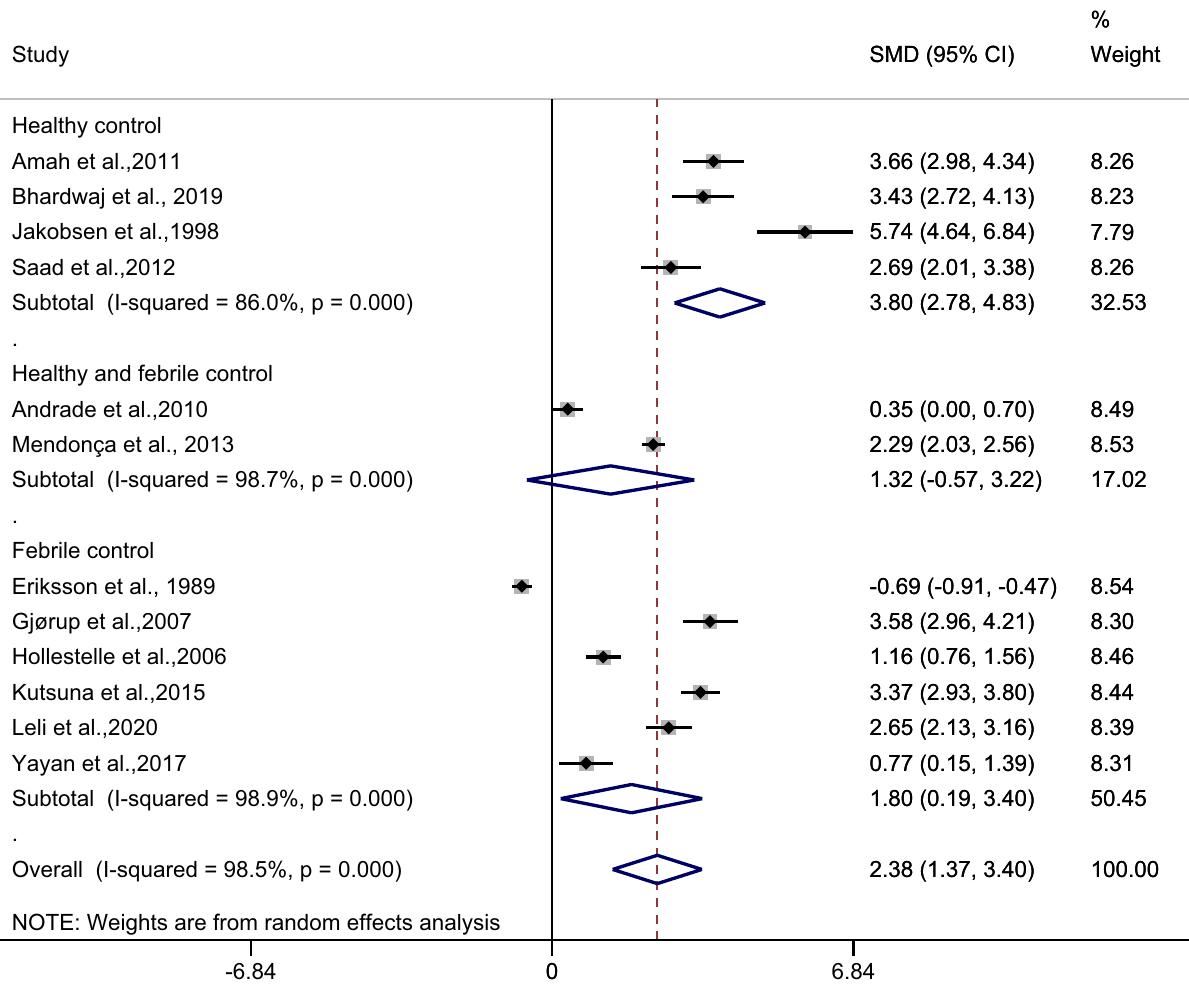
Figure 6. Forest plot demonstrates the difference in the mean CRP level between patients with uncomplicated malaria and healthy/febrile controls. SMD, standard mean difference; CI, confidence